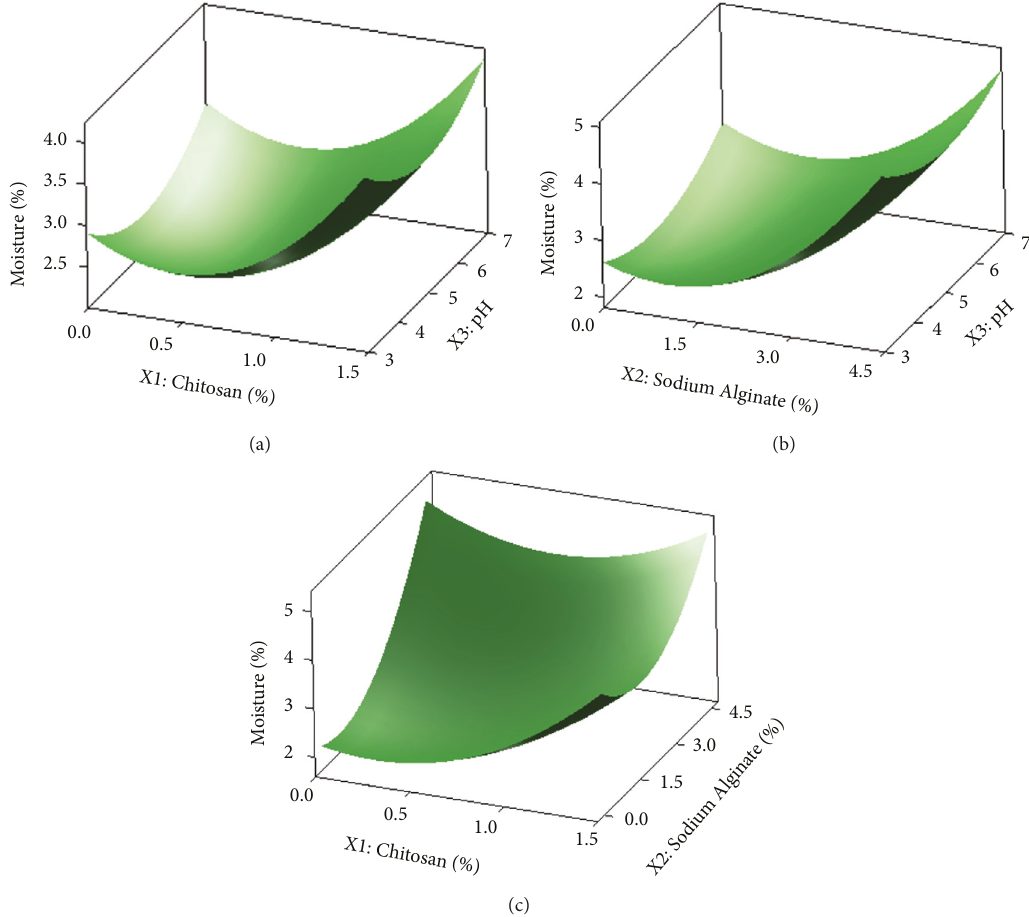
Figure 5: Three-dimensional plot of microencapsulate moisture content. (a) Microencapsulate moisture content vs. chitosan concentration. (b) Microencapsulate moisture content vs. sodium alginate concentration. (c) Microencapsulate moisture content vs. chitosan concen- tration and sodium alginate